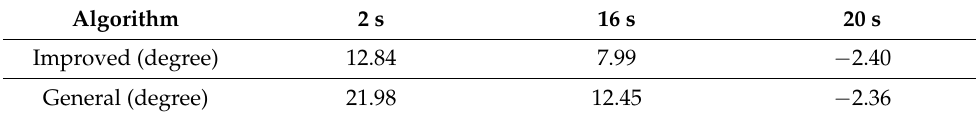
Table 2. Maximum front wheel angle error.